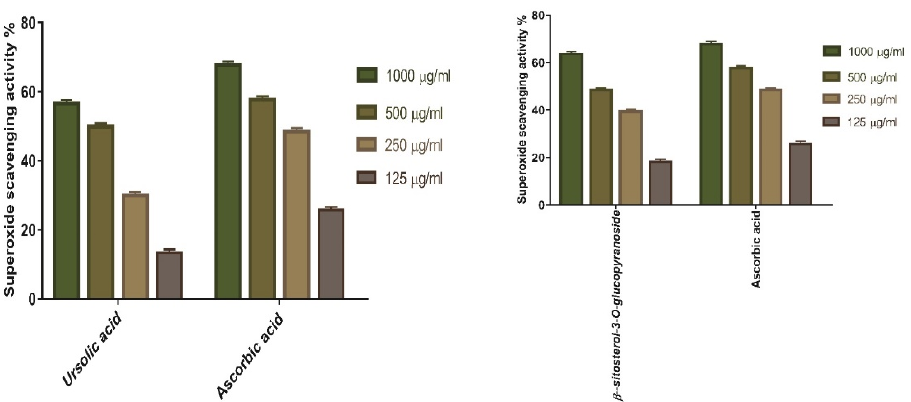
Figure 15. Superoxide radical scavenging potential of ursolic acid as well as β -sitosterol-3-O-glucopyranoside at variant concentrations (1000 µ g/mL, 500 µ g/mL, 250 µ g/mL, and 125 µ g/mL). Bars represent mean ± SD (standard deviation). Significant differences between groups are investi- gated by a